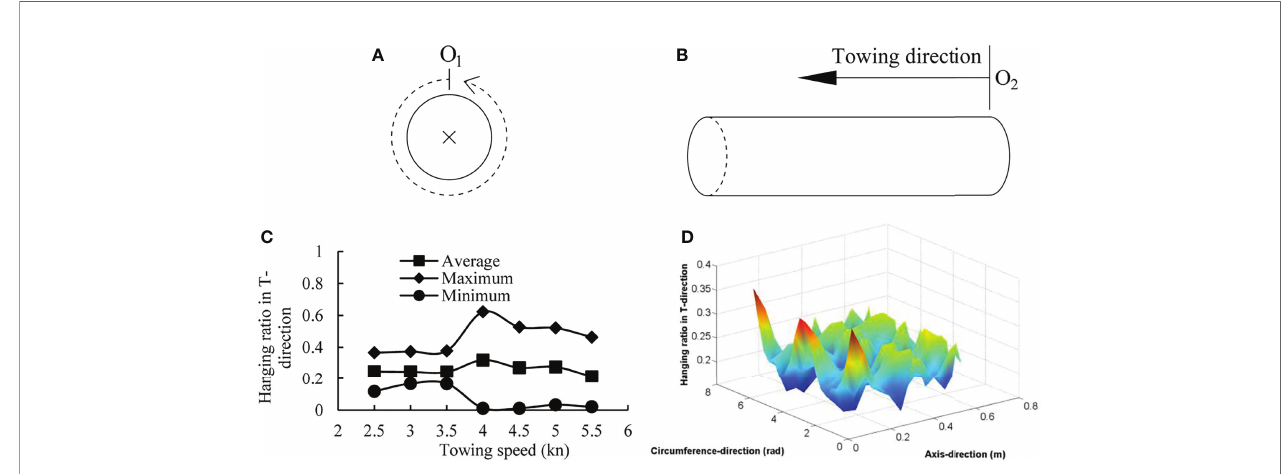
FIGURE 12 | Mesh opening performance of the codend. (A) The origin O 1 (midpoint of back net) and positive direction (anticlockwise) in the circumference- direction, ×: towing direction vertical inward; (B) the origin O 2 (end of the codend) and positive direction (towing direction) in the axis direction; (C) the average, maximum, and minimum hanging ratio in T-direction at different towing speeds; (D) the hanging ratio in T-direction at the towing speed of 3.5